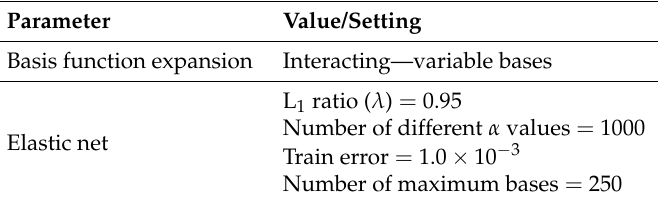
Table 3. FFX hyper-parameters used in our